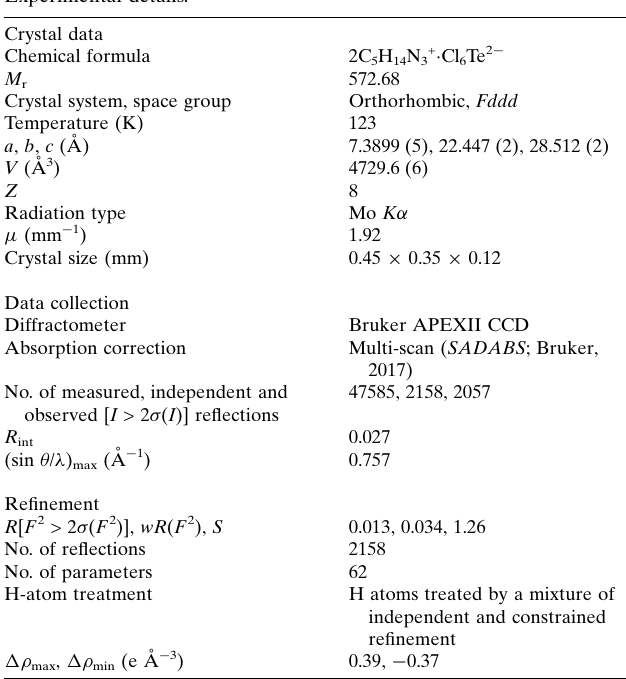
Table 2 Experimental details.